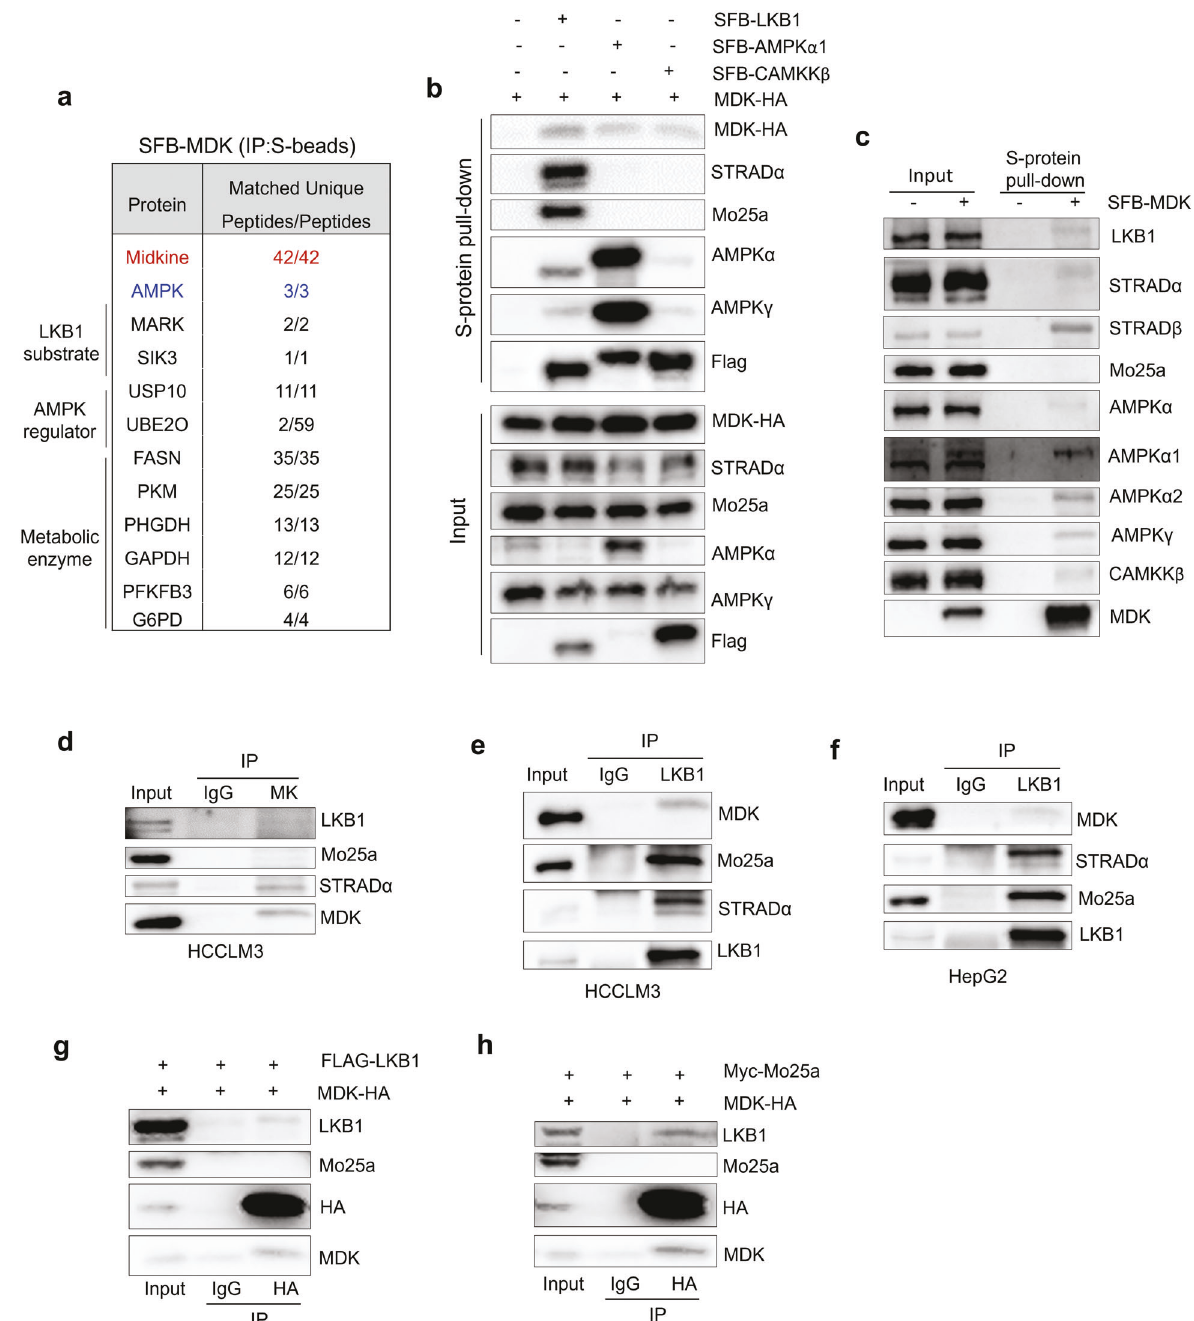
Fig. 2 Midkine associates with AMPK subunits and its upstream regulating factors. a AMPK kinase subunit and LKB1 substrates were identi fi ed as MDK-associated proteins in HEK293A cells by tandem af fi nity puri fi cation – mass spectrometry. Bait MDK protein is marked in red. AMPK α is marked in blue. The right column of numbers represents unique peptide number/total peptide number. b , c MDK associates with LKB1, CAMKK β , and AMPK subunits. The indicated constructs were expressed in the HEK293T cells for 24 h, and cell lysates were subjected to pull-down assays with S protein beads. d MDK was immunoprecipitated from HCCLM3 cells and subjected to Western blot analysis with antibodies against LKB1, Mo25a, STRAD α , and MDK. e – f LKB1 immunoprecipitated from HCCLM3 ( e ) and HepG2 ( f ) cells and subjected to Western blot analysis with antibodies against MDK, Mo25a, STRAD α , and LKB1. g – h HEK293T cells were cotransfected with MDK-HA and Flag- tagged LKB1 ( g ) or Myc-tagged Mo25a ( h ) and coimmunoprecipitated with HA primary antibody and subjected to Western blot analysis with antibodies against LKB1, HA, Mo25a and